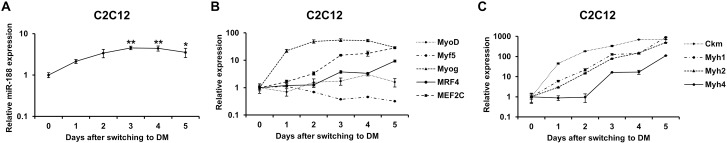
Expression pattern of miR-188 in C2C12 myoblasts during muscle differentiation.(A) Changes in miR-188 expression in differentiating C2C12 cells after switching to differentiation medium (DM) were analyzed by RT-qPCR (n = 4). (B) Expression patterns of 5 myogenic transcriptional factors, i.e., MyoD, Myf5, myogenin (Myog), MRF4, and MEF2C during C2C12 cell differentiation (n = 3). (C) Expression patterns of four differentiation markers, Ckm, Myh1, 2, and 4 during C2C12 differentiation. Data represent means ± SE. Statistical analysis was performed using Dunnett’s test; *P < 0.05, **P < 0.01 compared to 0 day.